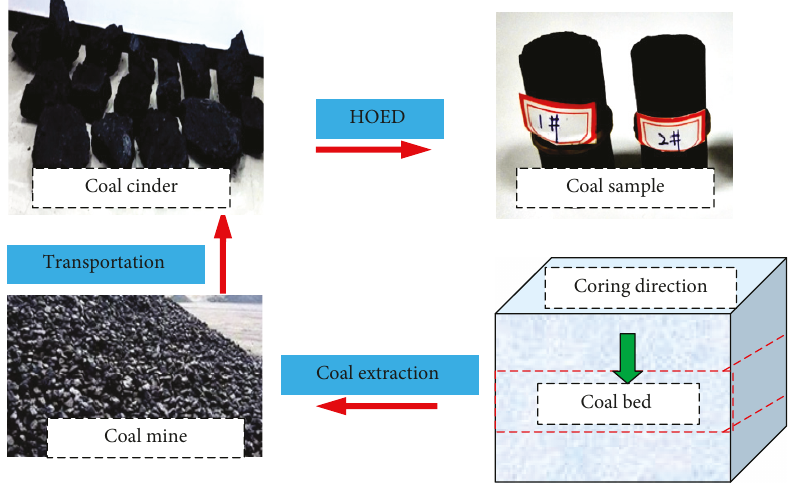
Figure 1: Schematic diagram of coal sample